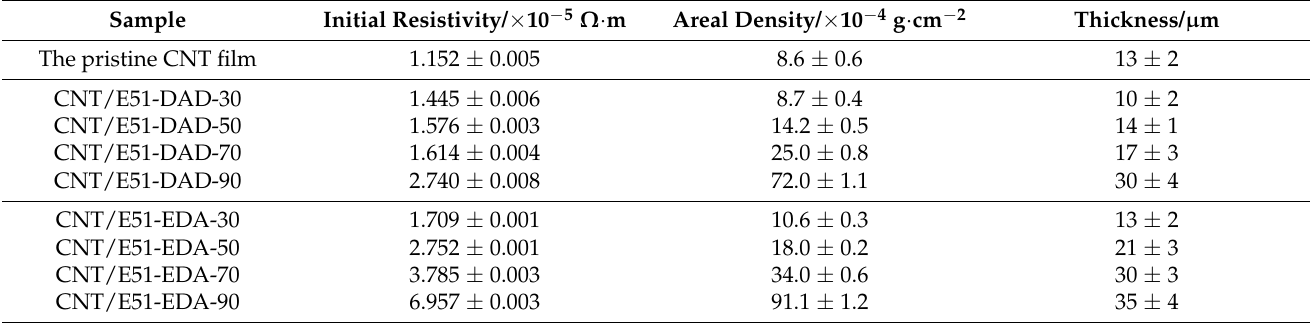
Table 1. The initial resistivities, the areal densities, and the thicknesses of the pristine CNT film and CNT/epoxy composite films before curing.